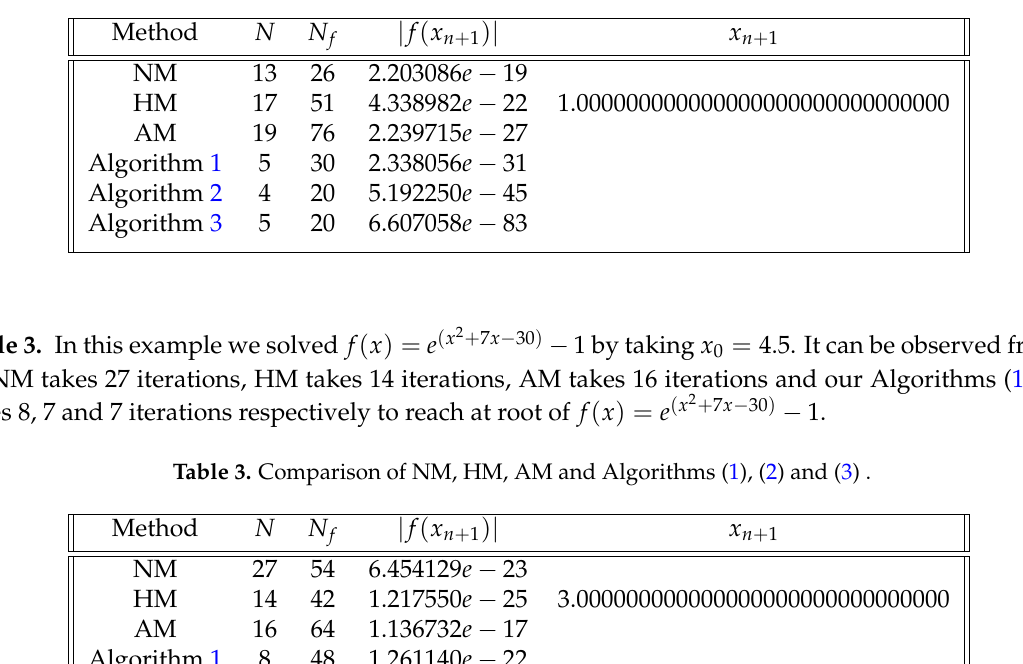
Table 2. Comparison of NM, HM, AM and Algorithms (1), (2) and (3) .